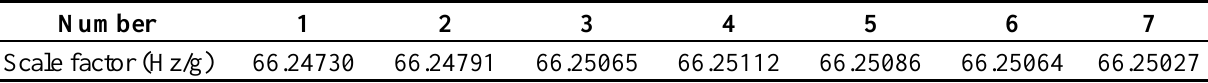
Table 5. The scale factors of the seven measurements for seven start-ups.